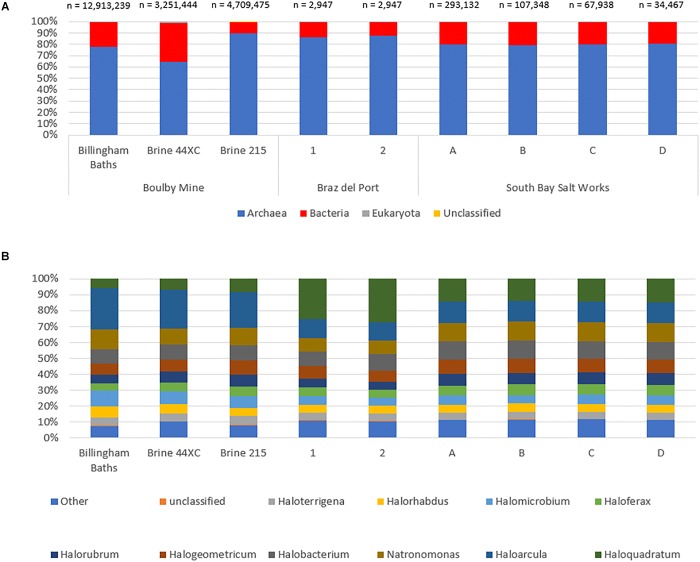
The taxonomic structure of the Boulby brines and a range of surface hypersaline brines as a percentage abundance by domain (A), and top 10 genus in archaea (B). Archaea dominate all three of the brines with bacteria making up a secondary portion of the brines. Eukaryotes and virus are the minority of sequences in all three. Note the different total sequence numbers for each metagenome.